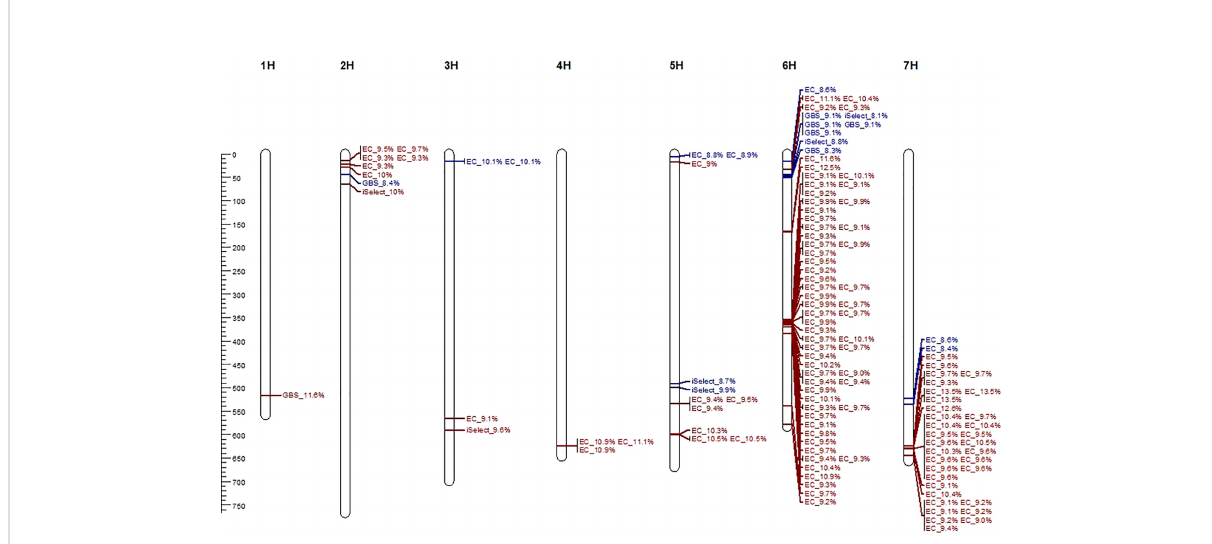
FIGURE 3 Physical map (positions in Mb) of the seven barley chromosomes and 70 identi fi ed quantitative trait loci (QTL) for relative infection with P. hordei upon attM (red) or expR + ch (blue) priming, including information on marker type and explained phenotypic variance of each